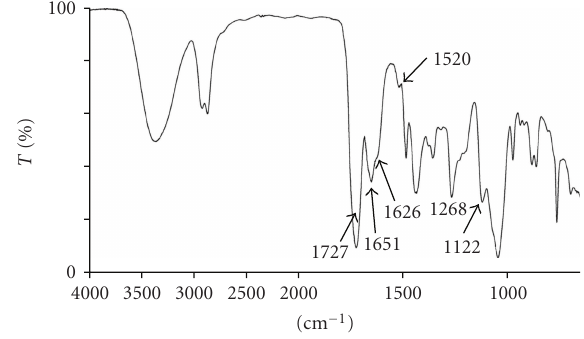
Figure 2: IR spectrum of the reaction product of BHEOA:EC 1:2 in the presence of 0.06mole K 2 CO 3 /mole OA at 140 ◦